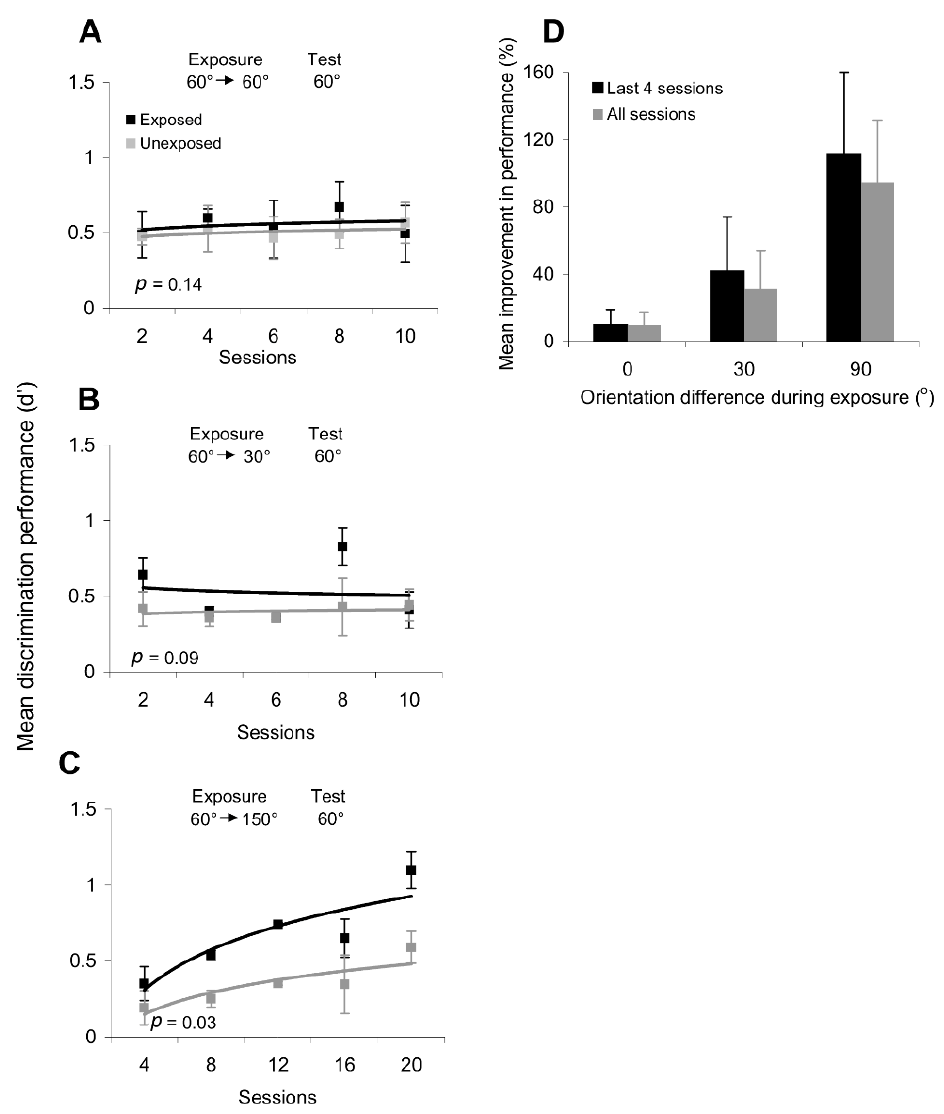
Figure 3. Changes in orientation discrimination performance (d’) after exposure to different orientation sequences. ( A , B ) Repetitive exposure to one orientation (60°) does not alter orientation discrimination performance around ( A ) and orthogonal ( B ) to the exposed orientation. ( C ) Exposure to non-orthogonal orientation sequences (60°—30°) does not lead to a significant change in the discrimination performance at the exposed location. ( D ) Exposure to orthogonal orientation sequences (60—150°) leads to a significant change in the discrimination performance around 60° at the exposed location. There was a similar improvement in discrimination performance around the orthogonal orientation (150°). This effect was measured over 20 exposure sessions and was statistically significant in each subject ( p < 0.05, Student’s t -test). Black line and symbols represent the orientation discrimination performance (d’) at the exposed location; gray line and symbols represent the orientation discrimination performance (d’) at the unexposed location. Error bars represent SEM.